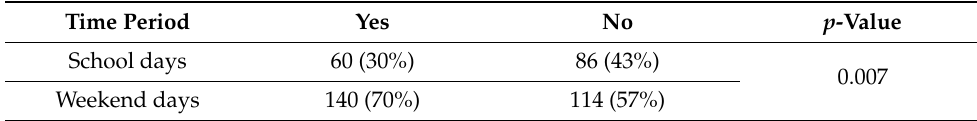
Table 3. Number (percentage) of children who consumed well-balanced breakfast every day on weekdays and weekend days.